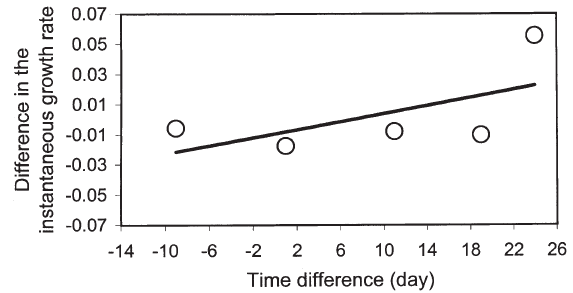
IG . 4. – Difference in instantaneous monthly growth rate (G) ver- sus overall time difference in day of the first component of Phycis blennoides with the fitted line (r=